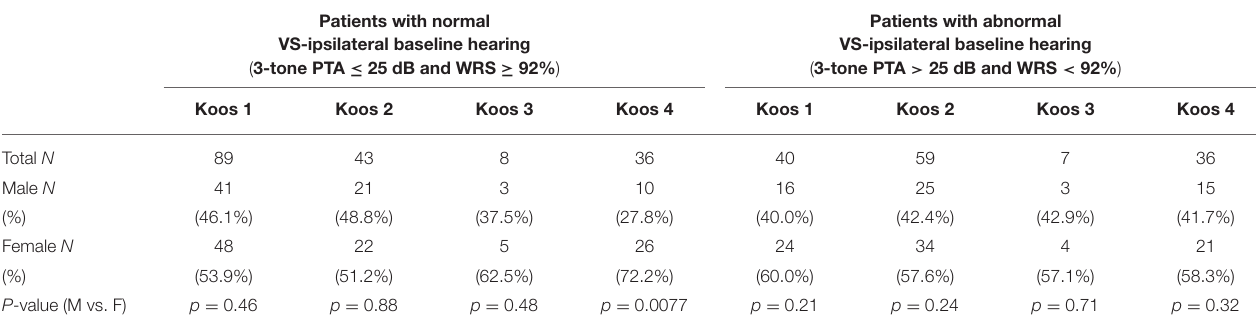
TABLE 4 | Sex distribution in patients with sporadic unilateral VS, segmented by baseline hearing and tumor Koos classification. Patients with normal VS-ipsilateral baseline